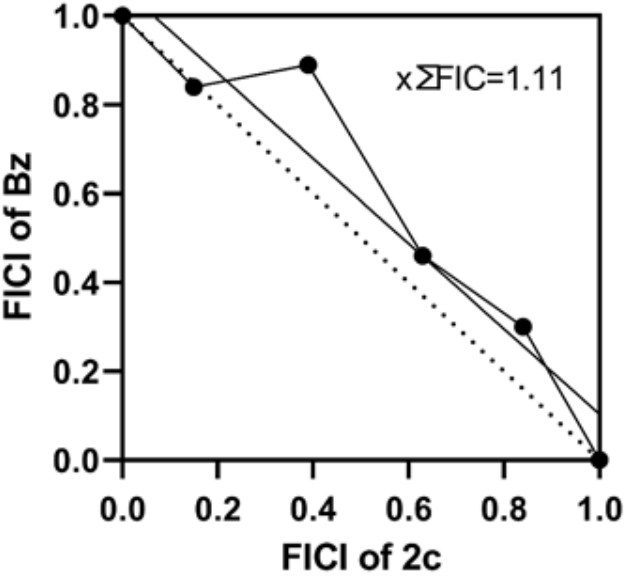
Figure 8. In vitro combinatorial activity of 2c and Bz against the amastigote forms of T. cruzi . FICI values were calculated based on IC 50 values of combinations. Isobologram graph was plotted with FICI